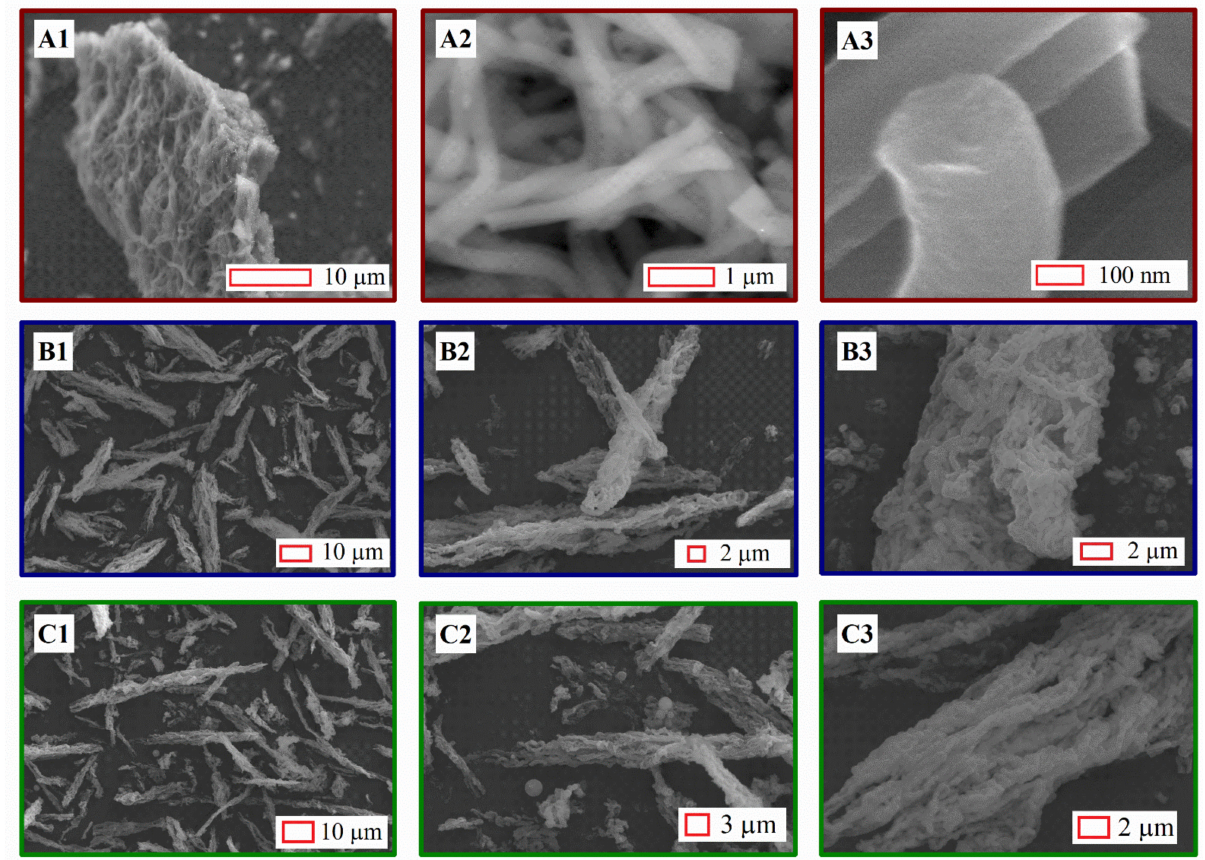
Figure 1. SEM images of ( A ) carbon microfibers, ( B ) SBA-15, and ( C )